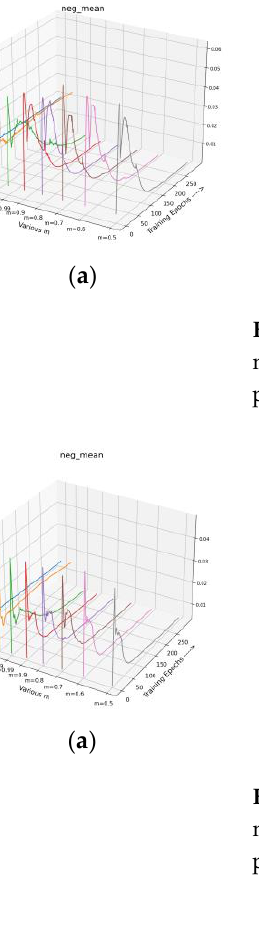
( d ) Figure 16. Classification accuracies over different values of T and h : ( a ) the Indian Pines dataset; ( b ) the Pavia University dataset; ( c ) the Houston dataset; ( d ) the Chikusei dataset. As illustrated by Figure 16, 𝑇 and ℎ are set to the optimal value for different da- tasets. Specifically, the values of 𝑇 and ℎ are 1.0 and 15 for the Indian Pines dataset, re- spectively, while 𝑇 is 0.5 and ℎ are 25 for the Pavia University dataset, and 𝑇 is set to 0.125 and ℎ is set to 10 for the Houston dataset. For the Chikusei dataset, the best values of 𝑇 and ℎ are 0.125 and 25. (2) Experiments of Momentum Coefficient 𝑚 : Figures 17 – 20 show four types of sim- ilarity statistics employed when using various values of 𝑚 , including mean of negative similarity, variance of negative similarity, mean of positive similarity, and variance of positive similarity. It is worth noting that in the early training process, the values of simi- larity statistics are not as expected due to the queue initialization.